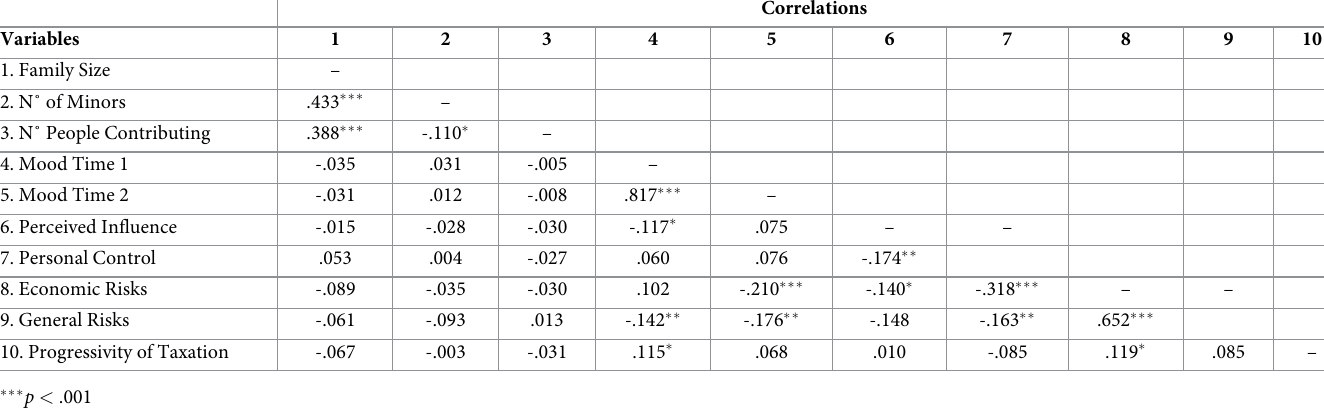
Table 1. Study 1 ( N = 306). Zero-order correlations among study variables (Family Size, Number of Minors in the Family, Number of People Contributing to the Family Income, Mood Time 1, Mood Time 2, Perceived Influence, Personal Control, Economic Risks, General Risks, and Progressivity of Taxation).